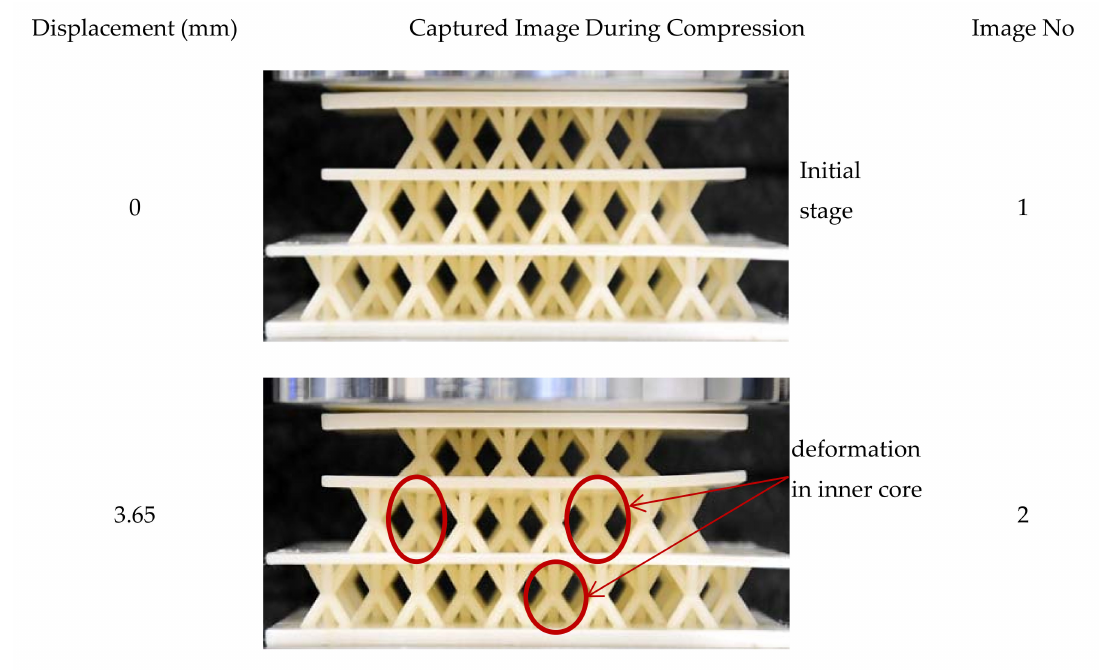
Figure 7. Load-displacement curves for ( a ) uniform and ( b ) graded density Kagome structures.